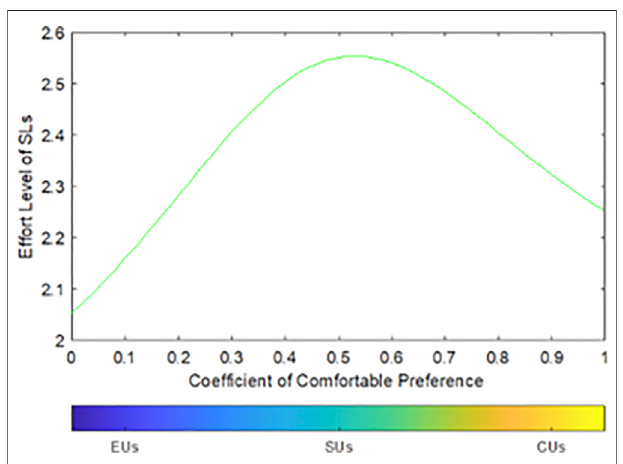
FIGURE 4 | Relationship between the effort level and SLs ’ preference in the case of asymmetric information.